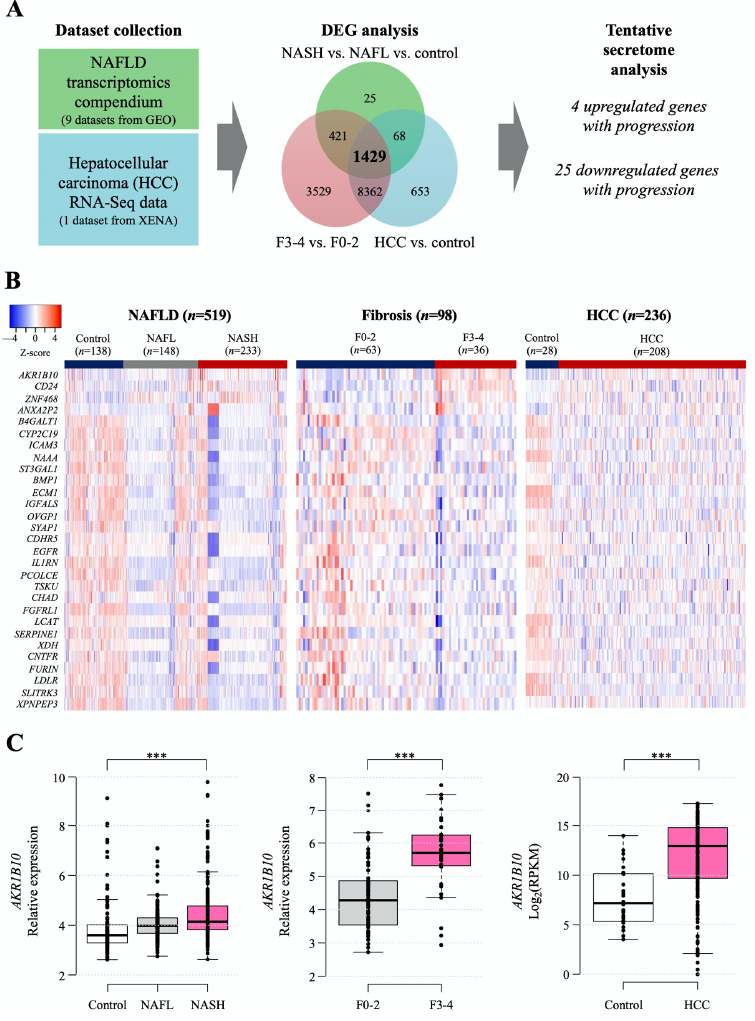
Figure 1. Computational identification of the tentative secretome reflecting NAFLD progression that was available from the analyses of public gene datasets. ( A ) Workflow of secretome identification by analyzing public datasets of NAFLD- and HCC-related genes. Detailed information on the datasets is described in Section 4 and presented in Supplementary Table S1. ( B ) Heatmap of putative secretory biomarker genes. Stepwise upregulated (upper 4 listed genes) and downregulated common genes (lower 25 listed genes) according to disease progression. ( C ) Hepatic AKR1B10 expression according to the progression of NAFLD was divided into 3 categories of disease progression. ***, p <